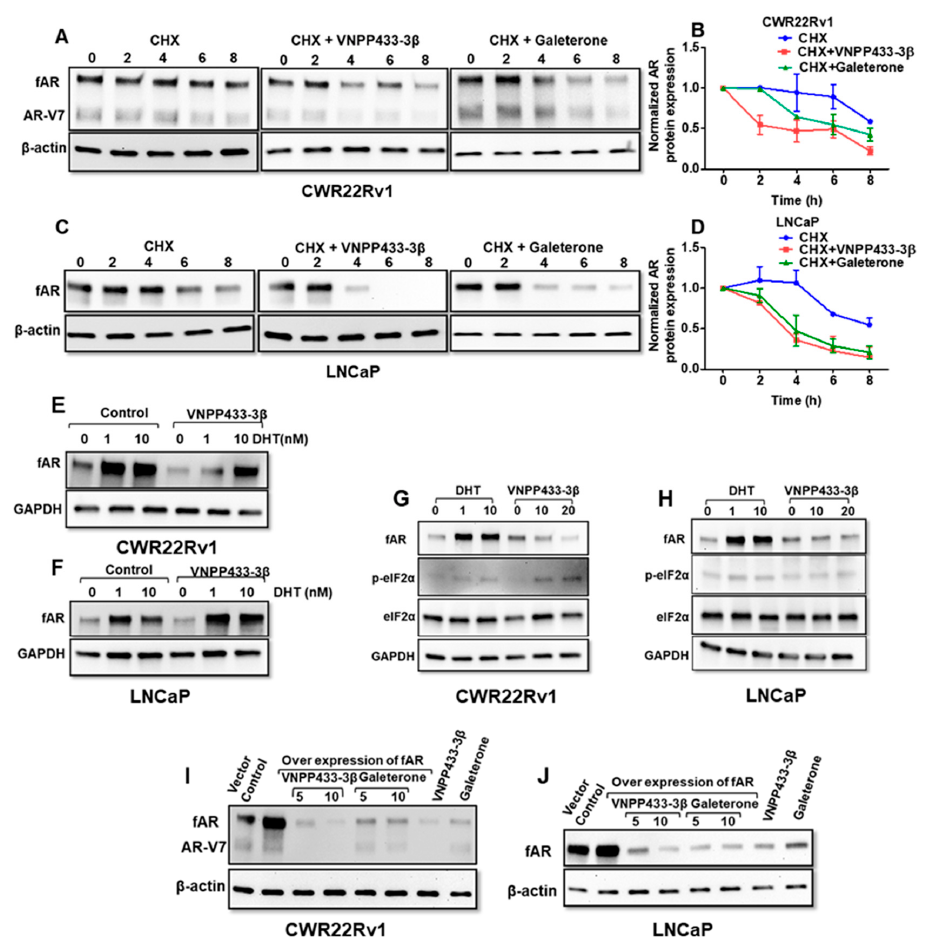
Figure 3. Evaluation of half-life of AR in presence of VNPP433-3 β using eukaryotic translation inhibitor cycloheximide (CHX). Androgen-deprived CWR22Rv1 ( A ) and LNCaP ( B ) cells were